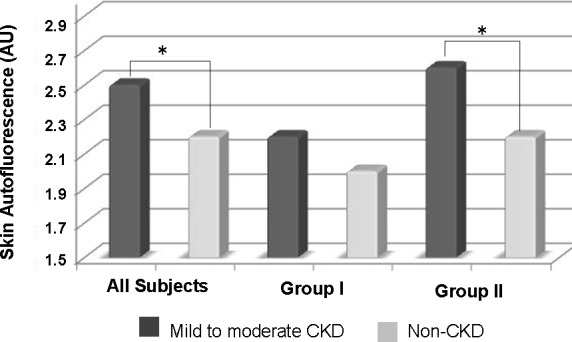
Skin autofluorescence according to the presence of atheromatous plaque between controls and patients with mild to moderate stages of CKD.CKD: chronic kidney disease; AU: arbitrary units; *: p<0.001; Group I: patients without and with mild atherosclerosis, in which the absence of plaques is mandatory; Group II: patients with moderate and severe atherosclerosis, in which presence of plaques is mandatory.